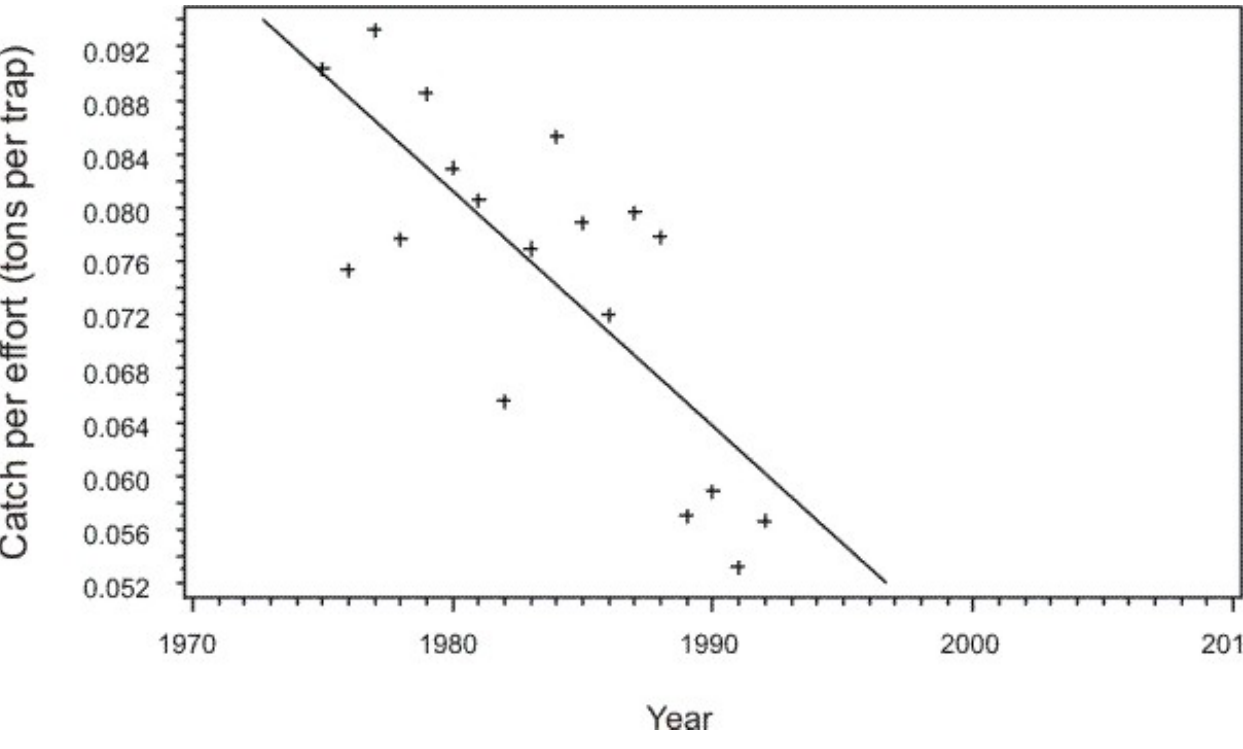
Fig. 4. Catch per effort for hard crabs in the Gulf of Mexico blue crab trap fishery by year. The linear trend was estimated using linear regression: y = - 0.00175 x + 3.54, where y is the catch per effort (tons/ trap) and x is the year; R² = 0.57, p =